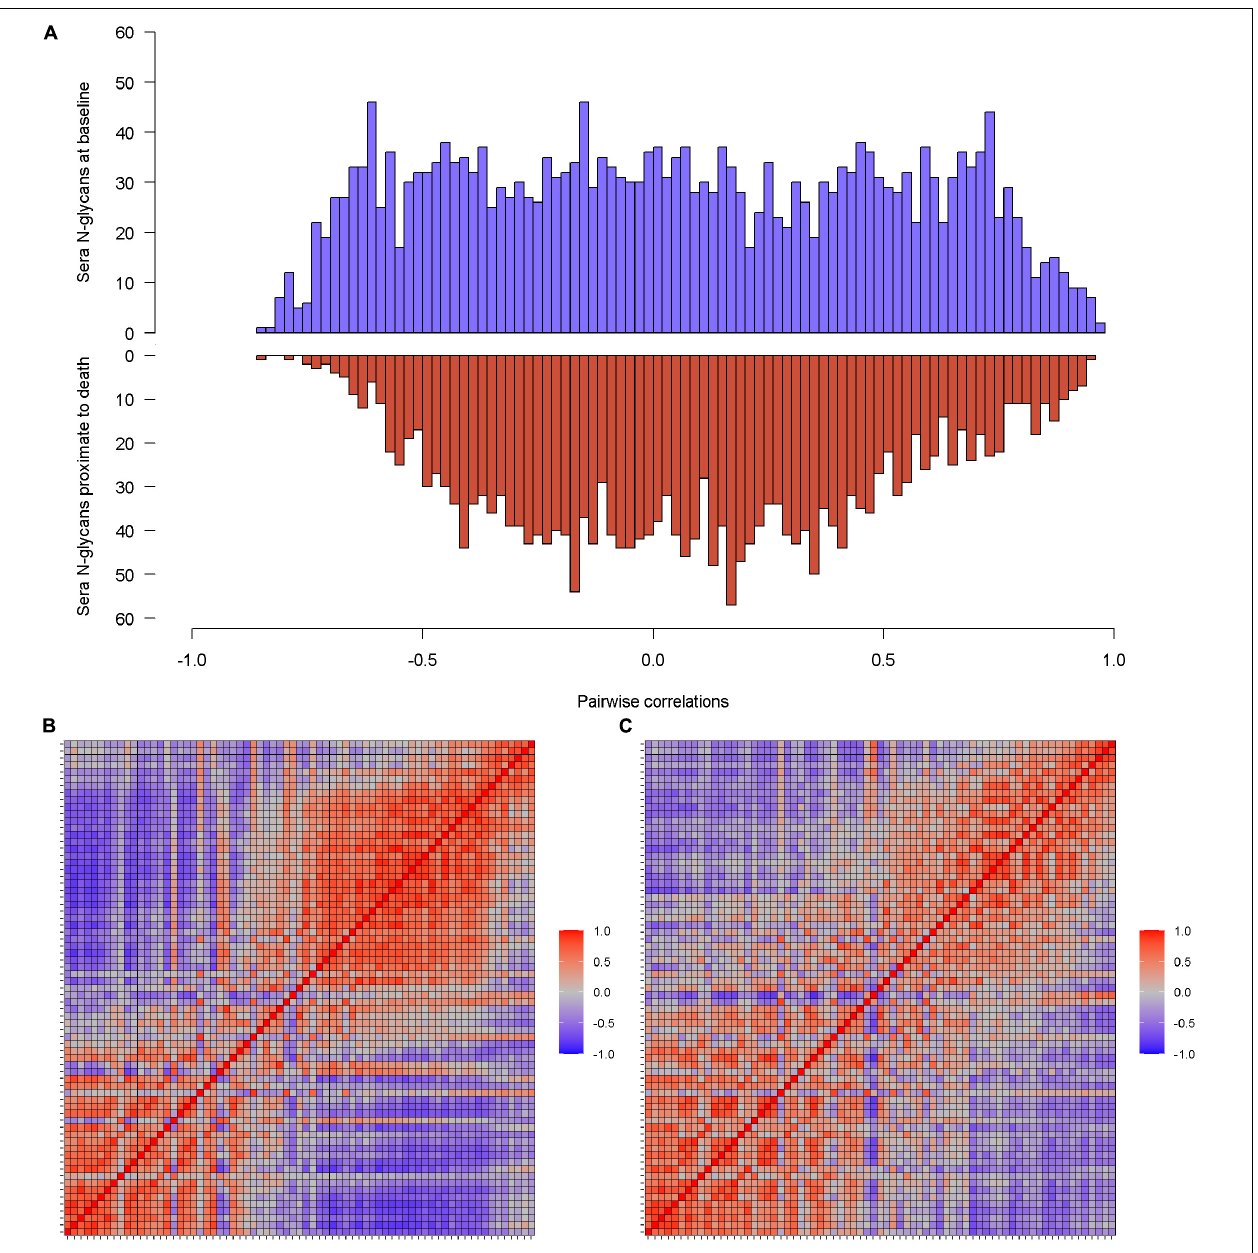
FIGURE 1 | Illustrates the correlations of individual sera N-glycans at baseline and separately proximate to death. (A) Is the histograms of pairwise correlations for sera N-glycans at baseline (blue) and proximate to death (red). (B,C) Are the heatmaps that further visualize the correlation patterns of sera N-glycan at baseline and proximate to